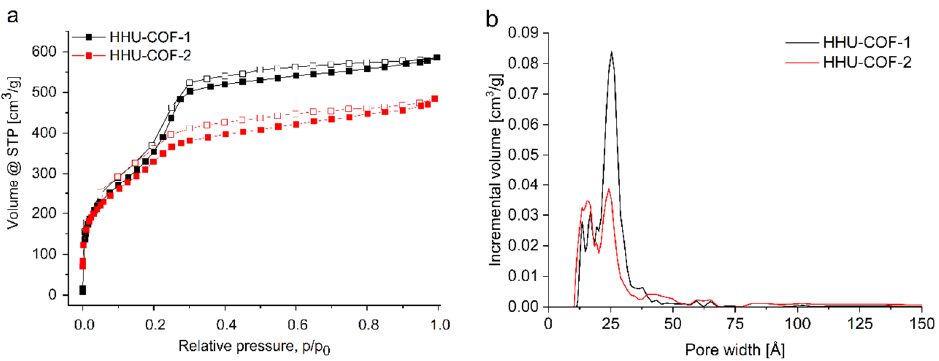
Figure 6. ( a ) Nitrogen sorption isotherms at 77 K and ( b ) pore size distributions of HHU-COF-1 and HHU-COF-2.